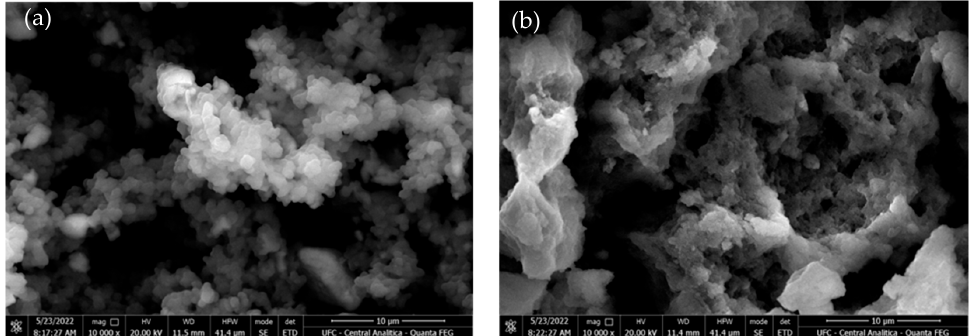
Figure 6. Electron microscopy of mCLEA-GLU-1.5 ( a ) and mCLEA-DEX ( b ), using 10,000× magnification.